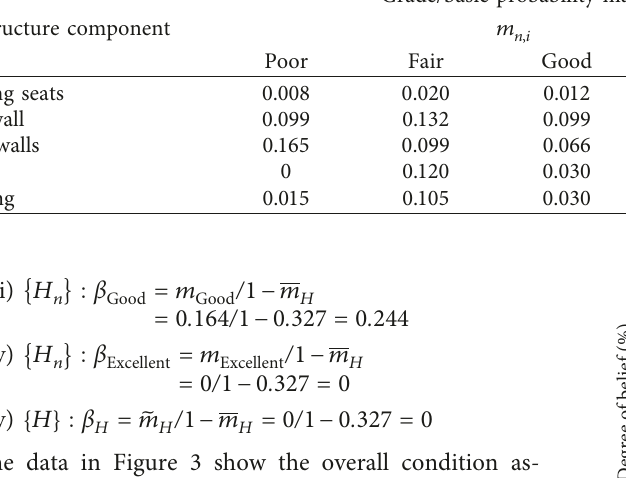
Table 8: Basic probability masses of the abutments elements considering the various assessment grades. Substructure component